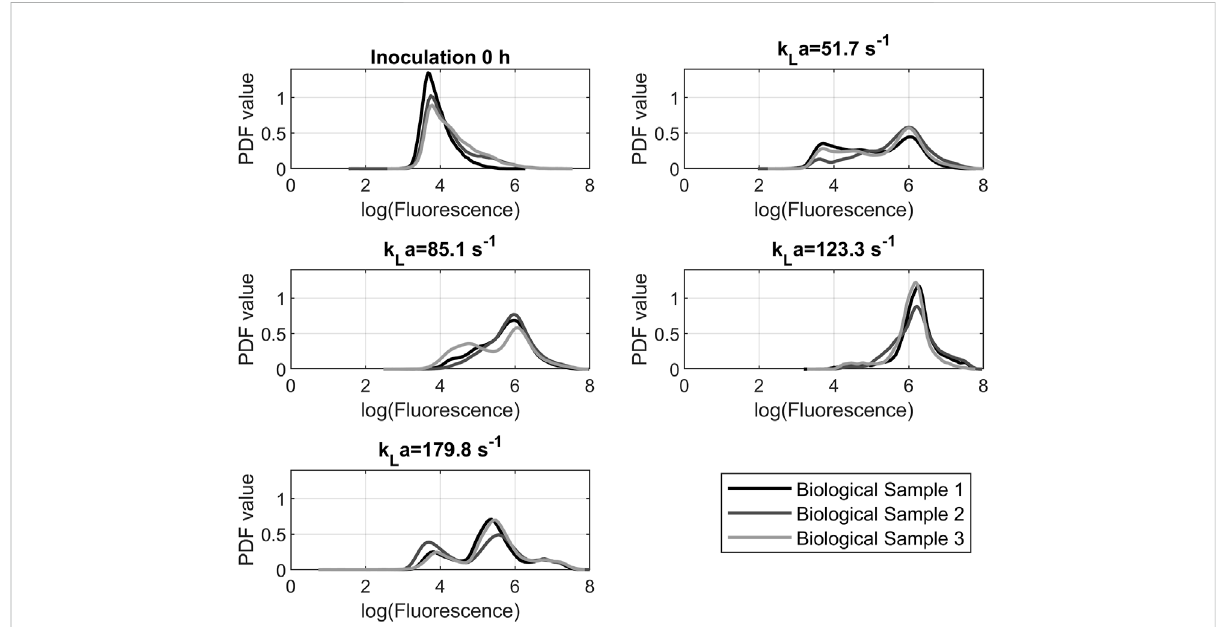
FIGURE 7 Probability density function of dihydroethidium fl uorescence data from cytometry measurements after 24 h. The peak location indicates the probability that a cell will fl uoresce at a certain level. The course of the graph indicates the distribution of fl uorescence in the cell